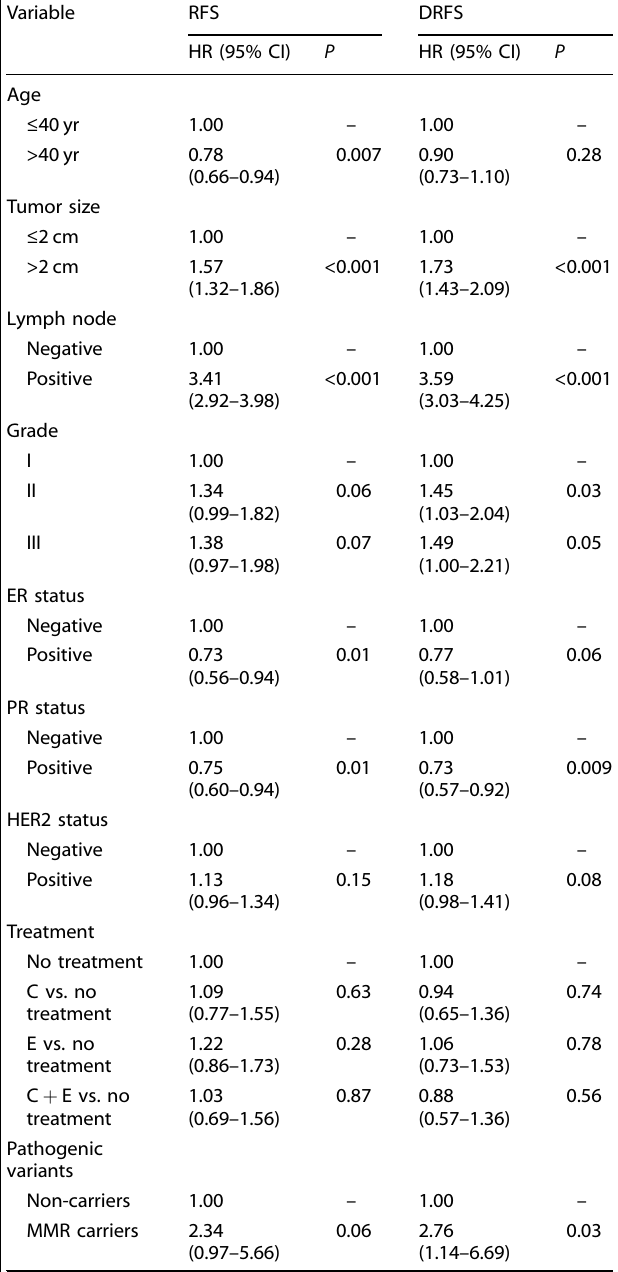
Table 3. Multivariate analyses of recurrence-free survival and distant recurrence-free survival in this